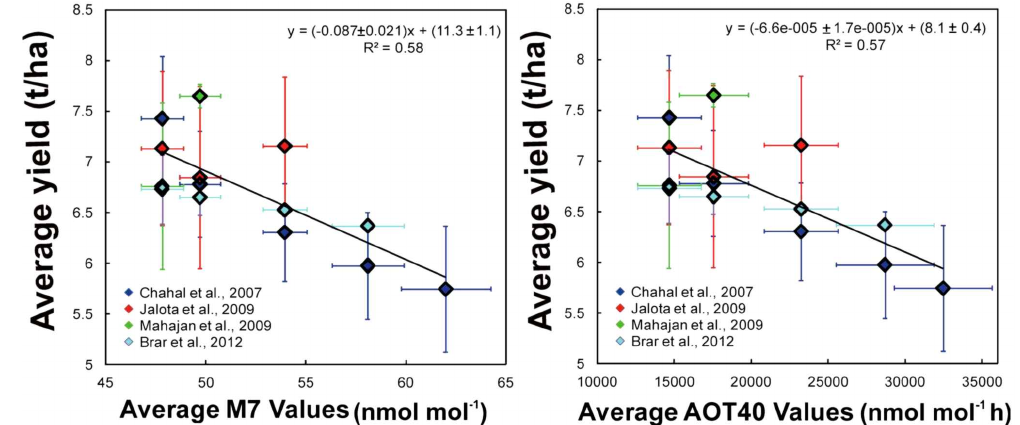
Figure 3. Empirical correlation of rice yields and ozone exposure indices for field studies with variations in sowing date. Ozone exposure for rice sown on different dates has been calculated using our data (Table 5). Yield data for rice have been taken from the peer-reviewed literature (Chahal et al., 2007; Jalota et al., 2009; Mahajan et al., 2009; Brar et al., 2012). Error bars on the x axis show the variance in the ozone exposure metrics for the same growth period (see Supplement S1 for definition) for different years. Error bars on the y axis show the variance in the yield obtained. Variance is introduced by replicating the study on several test plots (in different districts; plots with different soil properties using different cultivars) and in several years or by transplanting seedlings with a different age at the time of